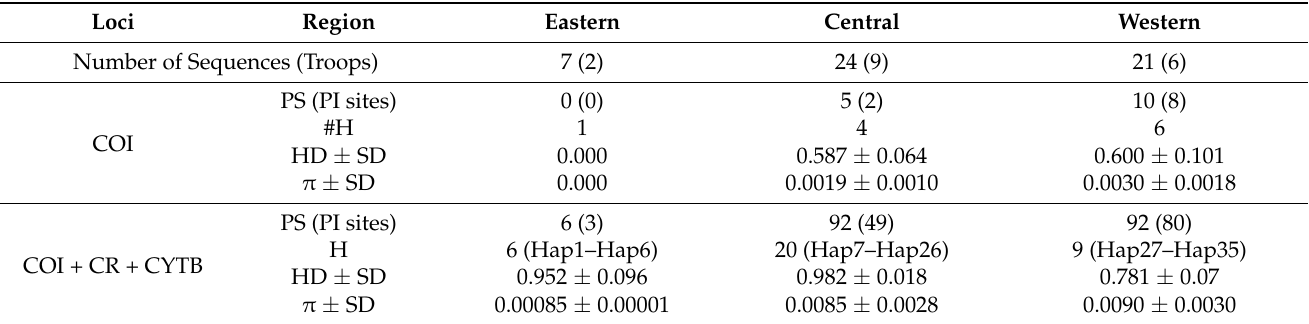
Table 2. Genetic diversity on COI (676 bp) and CYTB + COI + CR (2904 bp) sequences of the Nepal Himalayan langur